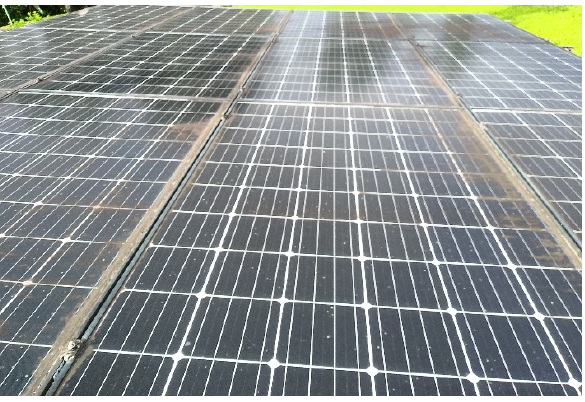
Figure 2. Monocrystalline PV module analyzed with the presence of natural non-uniform dirt.